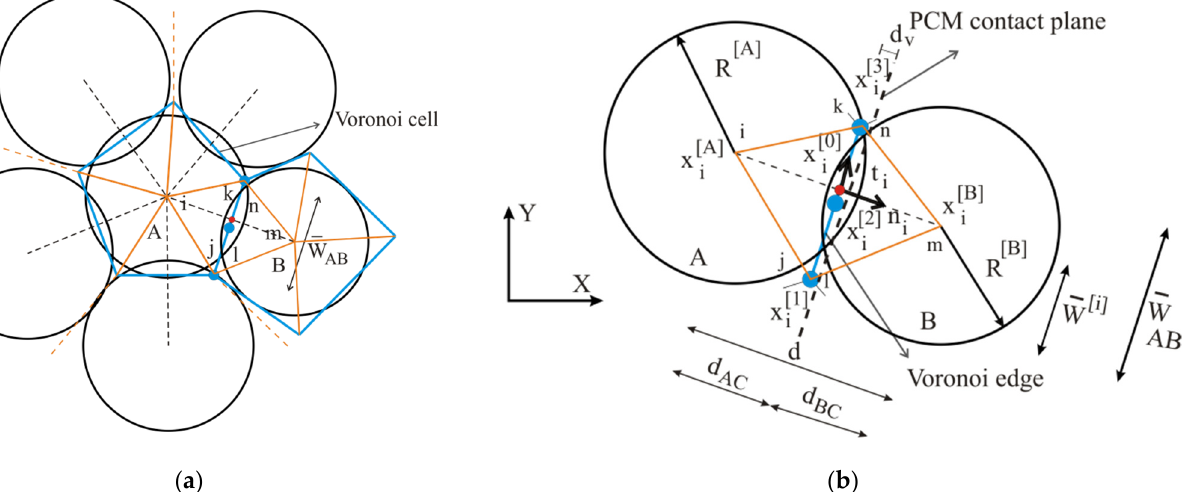
Figure 1. Flexible contact model for a discretization with three local contact points including tri- angular finite element mesh: ( a ) contact width and location at the Voronoi cell; ( b ) three local contact point scheme.